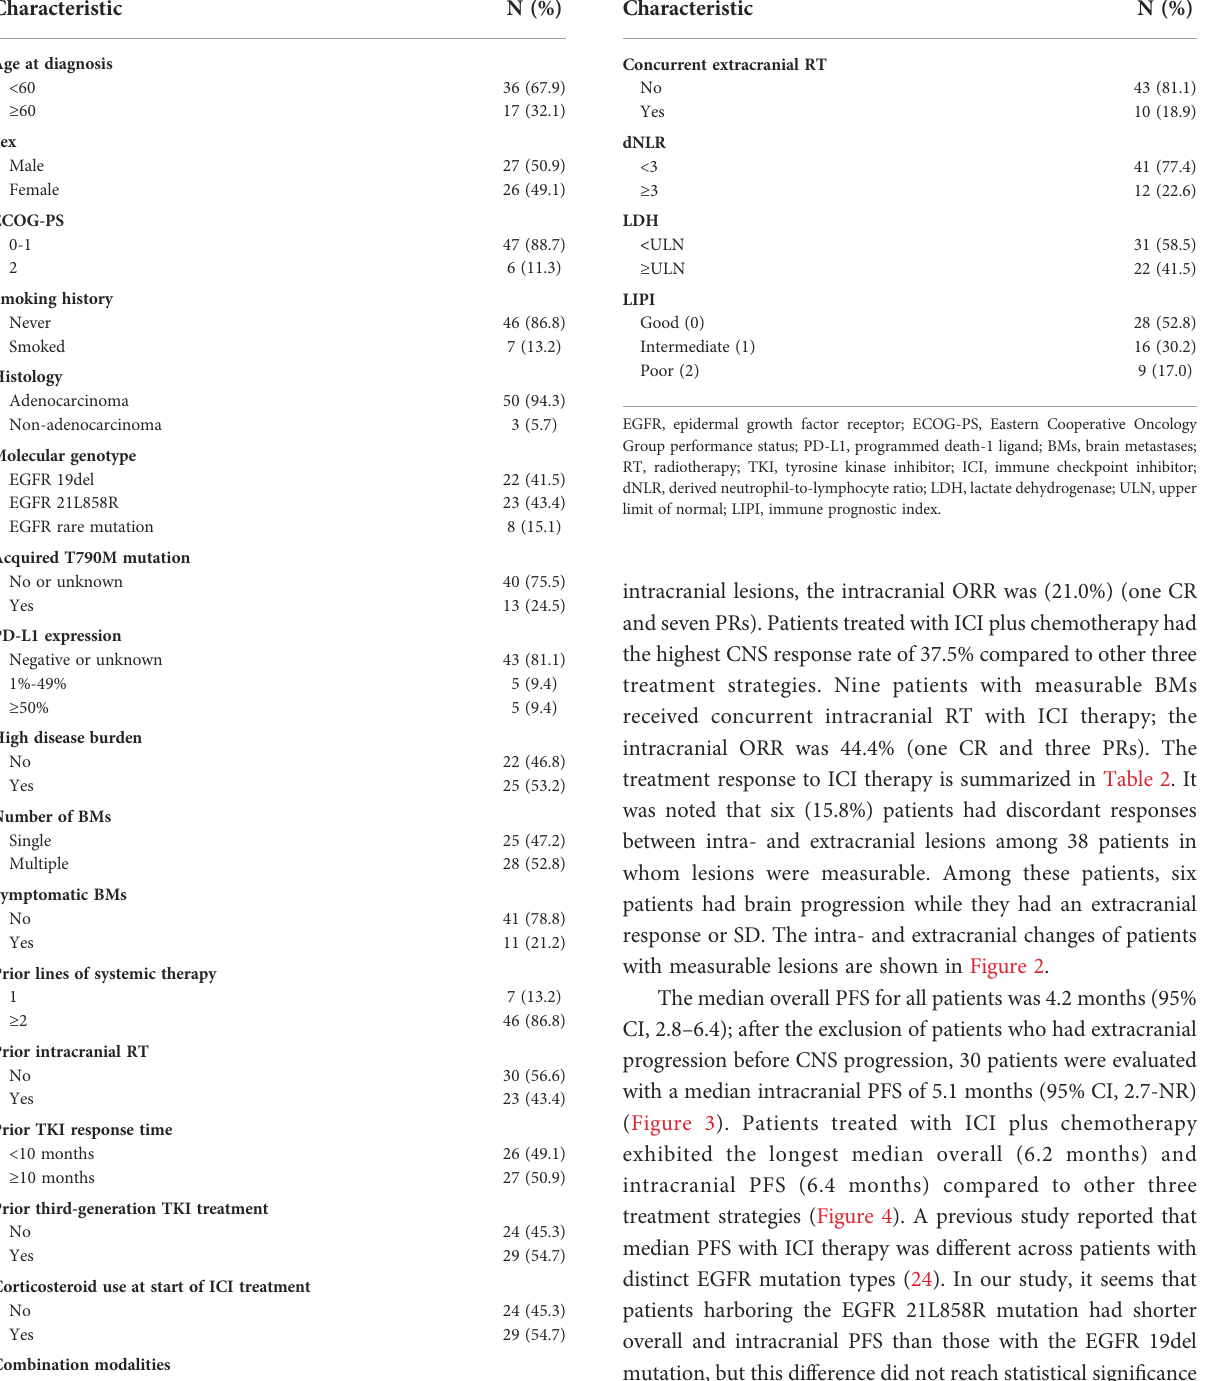
(overall PFS: 2.8 vs . 5.1 months, p = 0.360; intracranial PFS: 4.2 vs . 5.1 months, p = 0.650) (Figure 5).